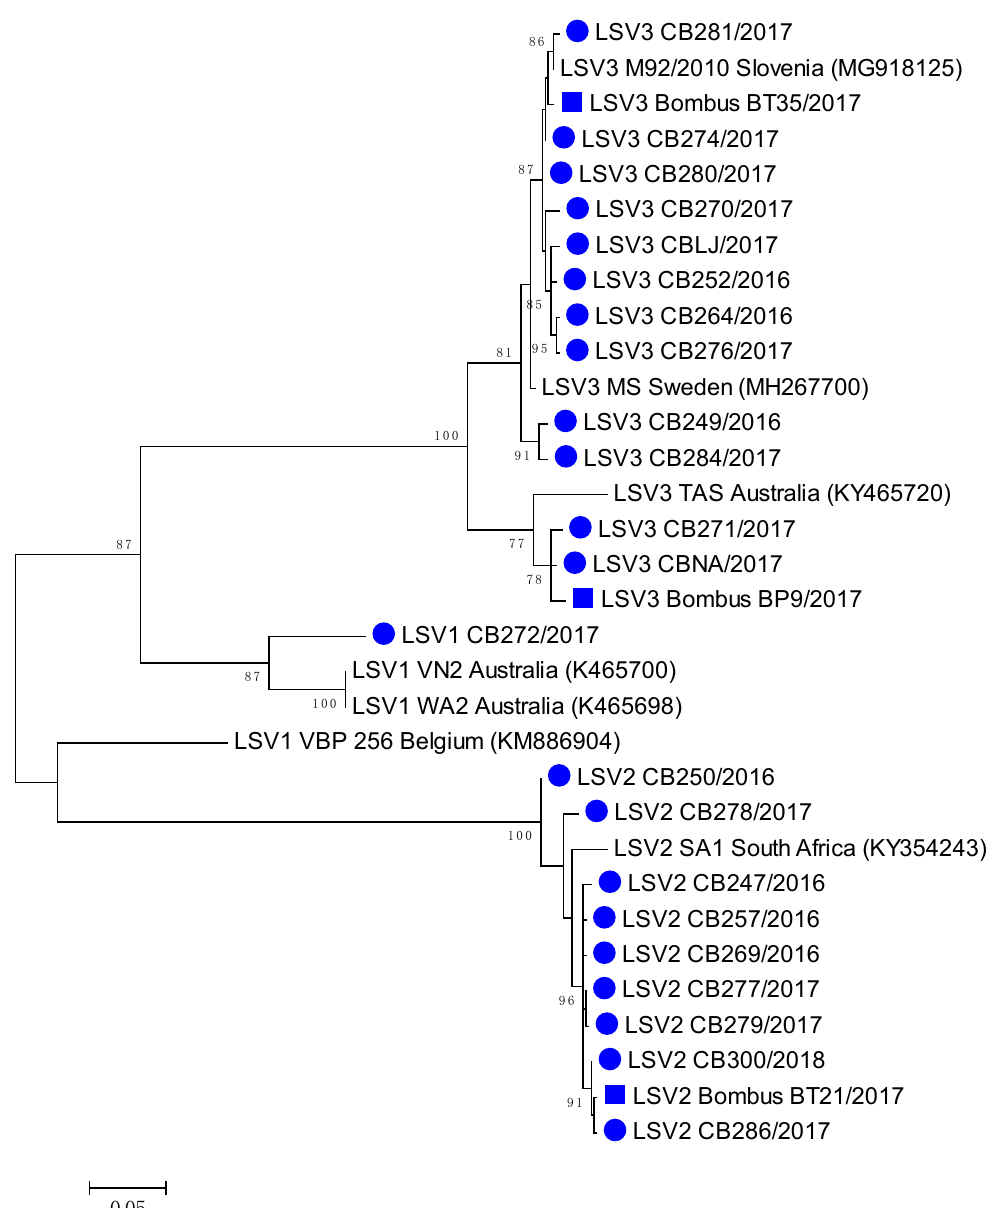
Figure 5. Phylogenetic comparison of the 22 LSV-positive in honeybees ( ● ) and three bumblebee ( ■ ) samples in Slovenia. The comparison was performed based on the 557 nucleotide sequences of the partial viral genome region encoding the RNA polymerase (nt genome position between 1778 and 2333, numbering according to strain LSV2/SI, MT482482), together with the seven genetically closest strains detected in GenBank (presented with accession numbers).